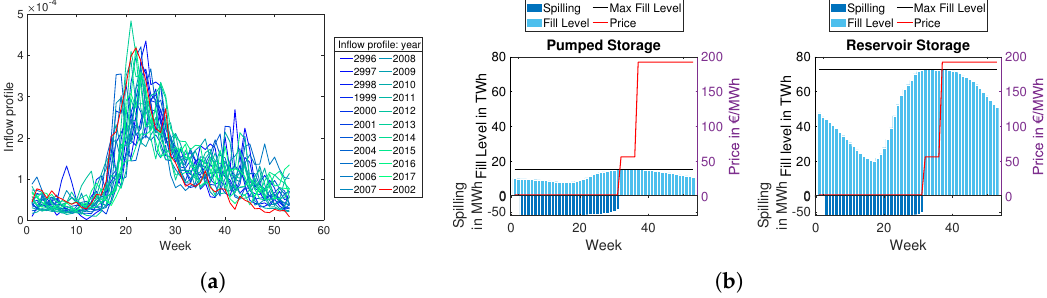
Figure A1. Reasons for special prices under the water inflow profile of the year 2002. ( a ) inflow profiles; ( b ) storage operation and electricity